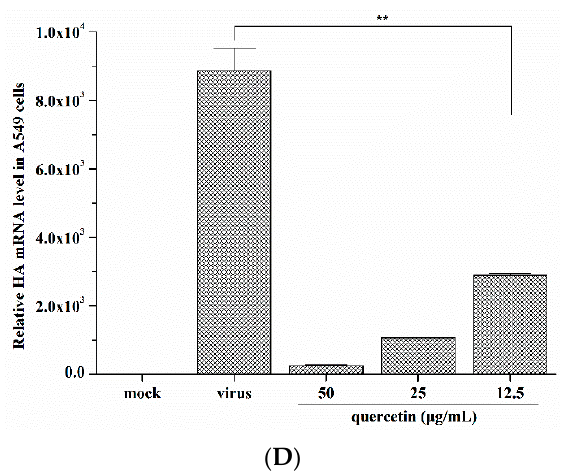
Figure 1. ( A ) The chemical structure of quercetin; ( B ) Validation of the protection of MDCK cells from influenza A/Puerto Rico/8/34 (H1N1) infection by quercetin. Original magnification, 40 ×. ( C , D ) The inhibitory effect of quercetin on the influenza A/Puerto Rico/8/34 (H1N1) HA mRNA expression in MDCK cells and A549 cells were detected by quantitative real-time PCR at 24 h post-infection. ** p < 0.05.